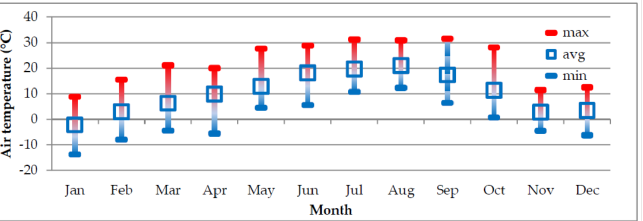
Figure 8. Monthly variation of the outdoor air temperature measured in Brasov 2020.